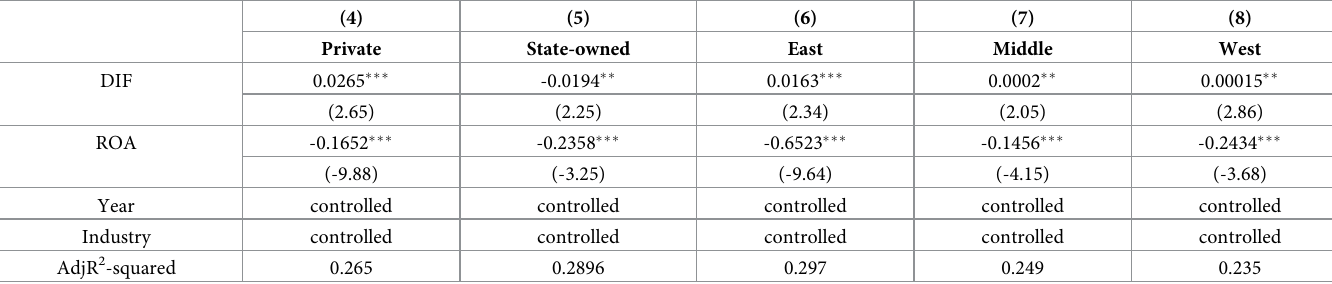
Table 3. Regression results of companies’ property rights and geographic